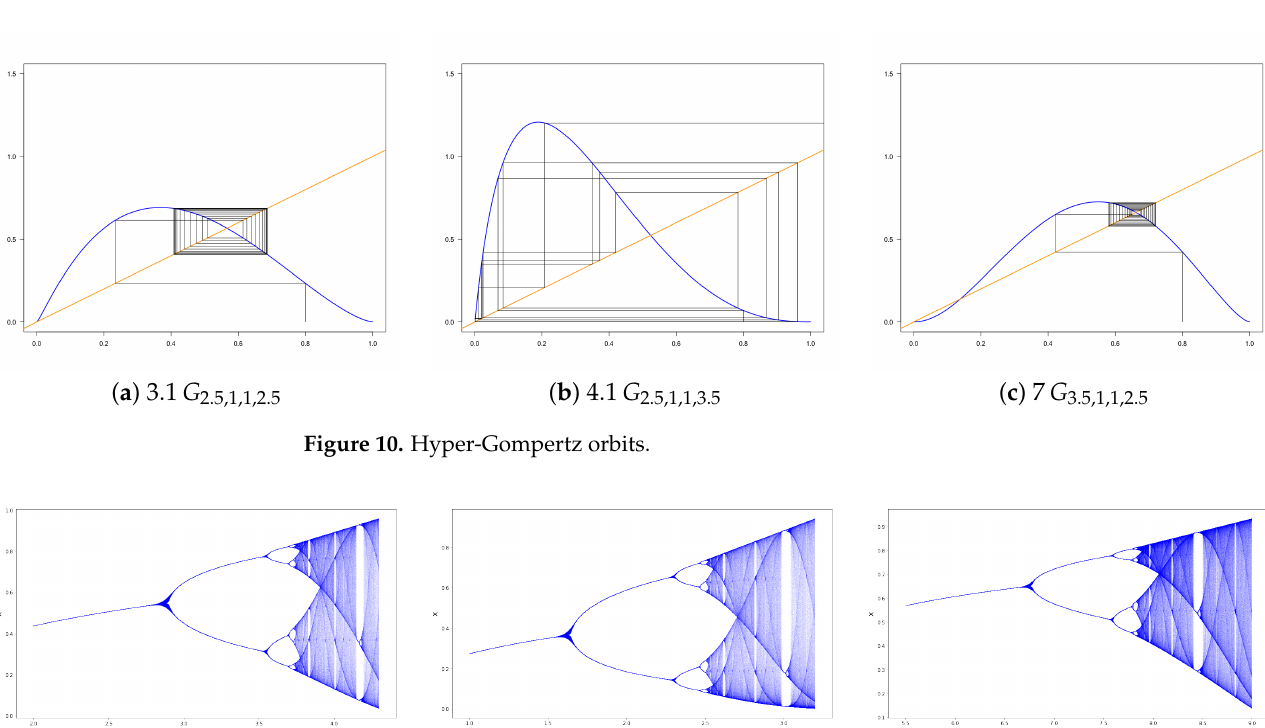
Figure 9. Schwarzian derivatives of r G p ,1,1, Ψ ( x ) = r x p − 1 ( − ln x ) Ψ − 1 .